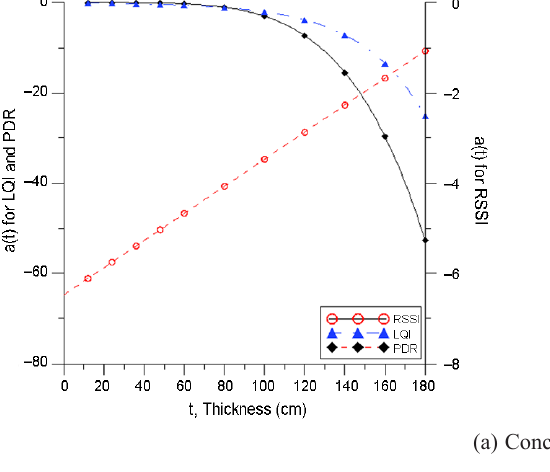
)(a) Concrete block